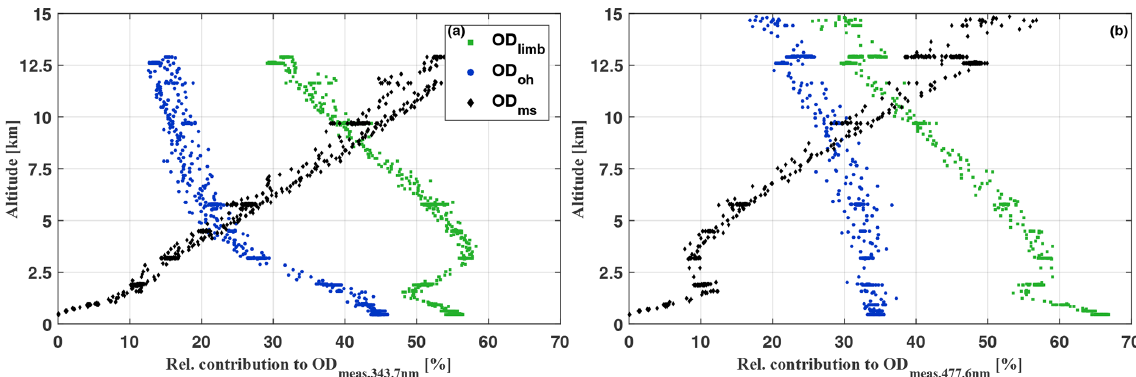
Figure 3. Relative contribution to the limb measured optical depth of O 4 at 343.7nm (a) and at 477.6nm (b) due to the absorption overhead of the aircraft (OD oh ), from multiple scattering (OD ms ), and within the line of sight of the telescopes (OD limb ) for the HALO flight on 11 September 2014 (AC11). For details see the